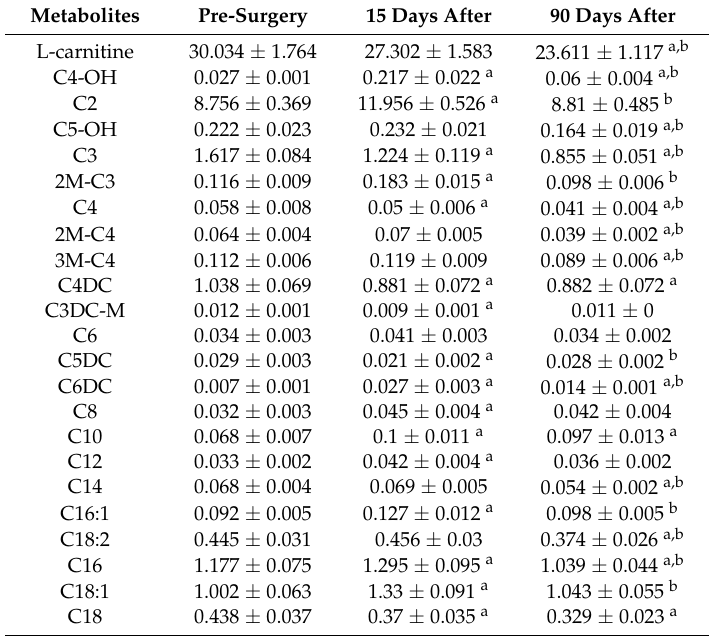
Table A1. Acylcarnitine concentrations ( µ M) in dried blood spots form patients before, 15 days and 90 days after RYGB surgery. total: sum of all quantified acylcarnitines; Medium chain (MC): sum of acylcarnitines with 6 to 14 carbons; Long chain (LC): sum of acylcarnitines with 16–18